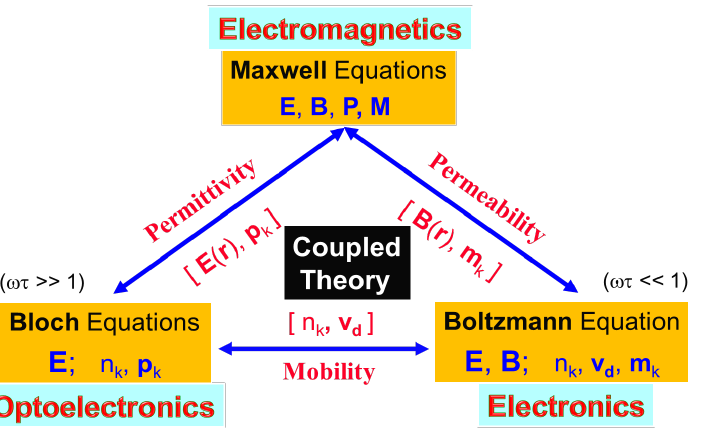
Figure 1. Illustration of a Device Modeling & Simulation Triangle for strong-coupling model ap- plied to multi-functional electro-optical devices, where the device electromagnetic, opto-electronic and electronic characteristics are fully described by coupled Bloch, Maxwell, and Boltzmann equa- tions all